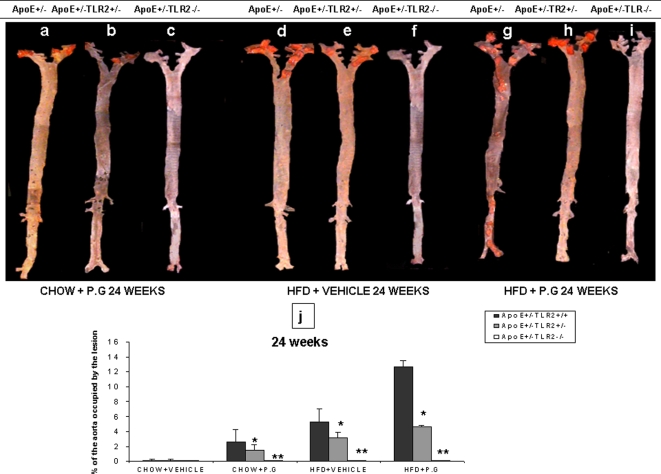

P. g and/or high fat diet increases aortic atherosclerotic lesions in ApoE+/−-TLR2+/+ mice when compared to ApoE+/−-TLR2+/−, and ApoE+/−-TLR2−/− mice.
En face analysis: (1A–1I): Representative en face view of aortic surface lesions in ApoE+/−-TLR2+/+, ApoE+/−-TLR2+/−, and ApoE+/−-TLR2−/− mice after 24 weeks of treatments. (1J): Calculated percentages of aortic surface area covered by lesions after 24 weeks of treatments (bacterial challenge or vehicle control) among mice of three genotypes maintained on standard chow or high fat diets. Values represent means±SD; *p<0.05 for ApoE+/−-TLR2+/+ mice compared to ApoE+/−-TLR2+/− mice and **p<0.05 for ApoE+/−-TLR2+/+ mice compared to ApoE+/−-TLR2−/− mice in the same treatment condition and maintained on the same diet. Abbreviations are as defined in the text.